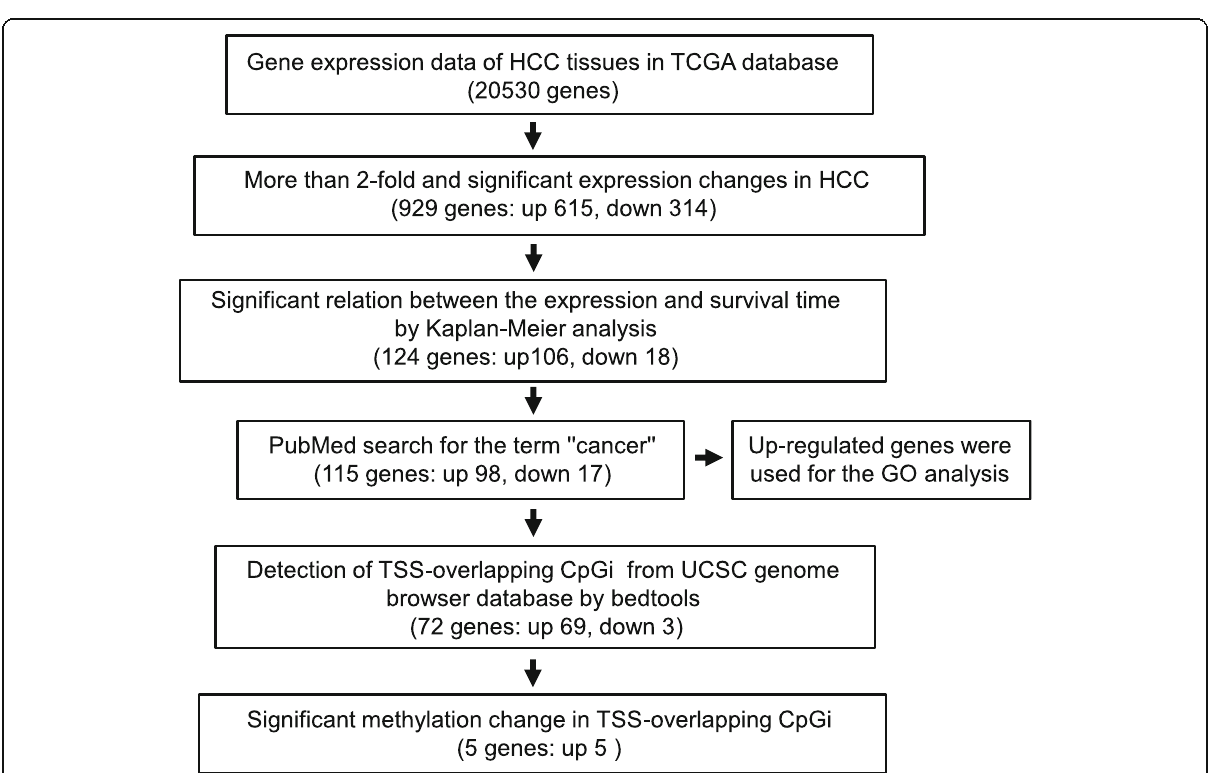
Fig. 1 A flowchart of the gene selection process. This shows the steps which we chose the final 5 genes out of the TCGA database